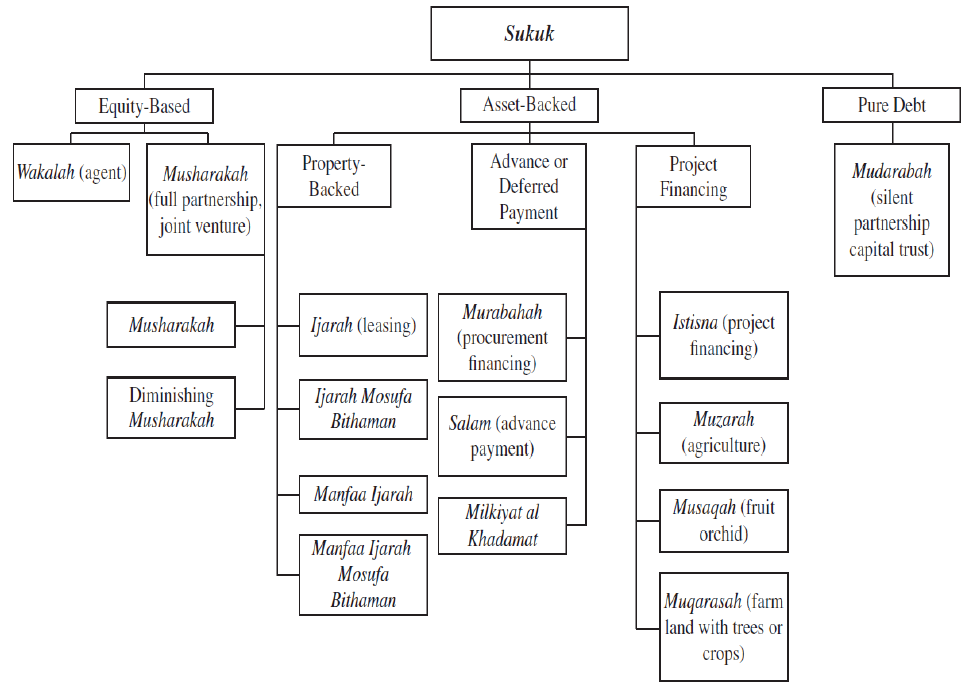
Figure 4-Classification of Sukuk Contracts Based on Their Financial Characteristics. (ARIFF, 2014, p